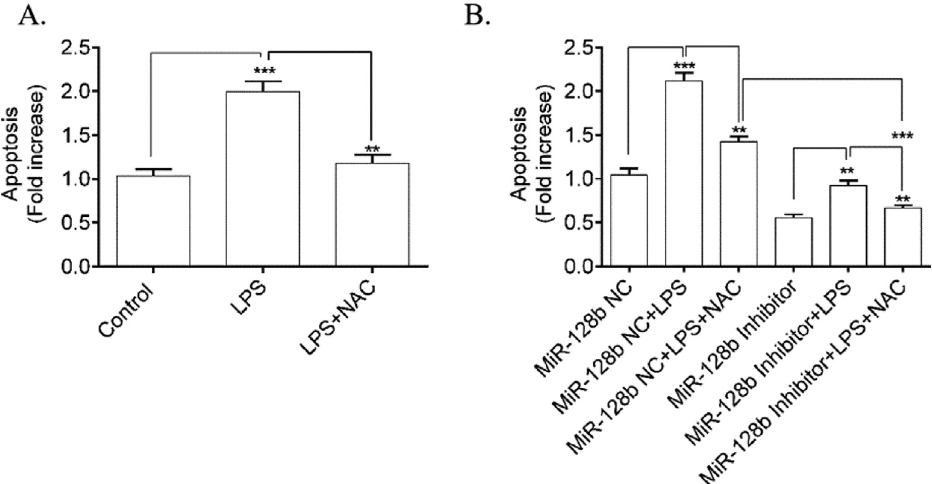
Figure 5. (A, B). Detection of human pulmonary microvascular endothelial cell (HPMEC) apoptosis via FCM analysis. Apoptosis was detected after 24h of transfection with an miR-128b inhibitor (50 nM) or NC (10 nM) and after 24 h treatment with Lipopolysaccharide (LPS) (1 μ g/mL) or NAC ( n = 4). Data are represented as mean ± SEM. * p < 0.05, ** p < 0.01, *** p < 0.001.